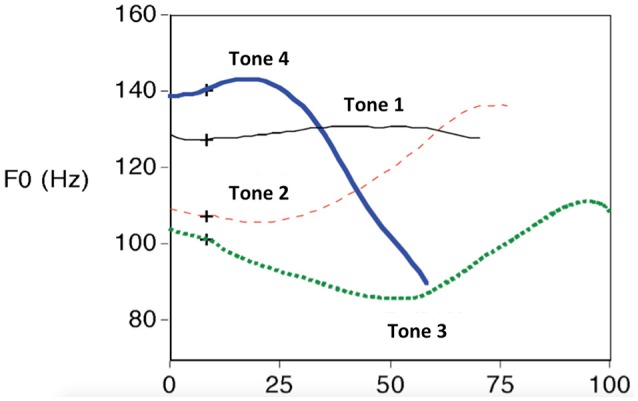
Mandarin tone produced in isolation. Modified from Xu (1997).